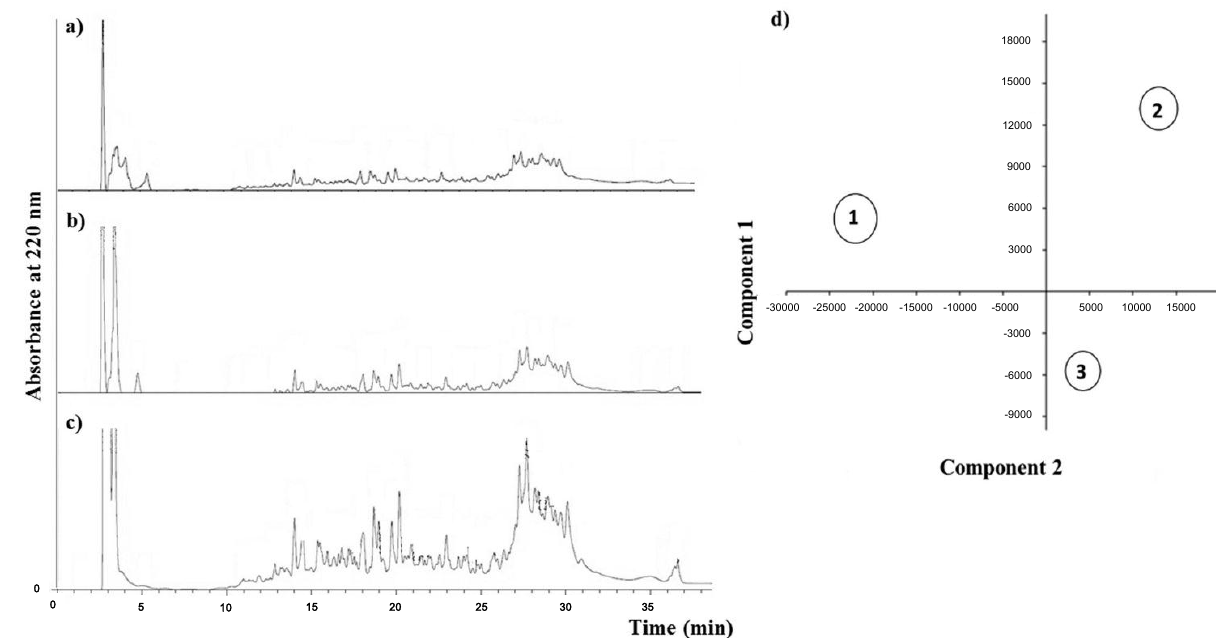
Figure 1. Representatives RP-HPLC profiles of the water-soluble extracts (WSEs) and PCA obtained from the yogurt studied in this work. The chromatograms are relative to yogurt fermented with only S. thermophilus and L. delbrueckii ssp. bulgaricus (CNT) after 1 ( a